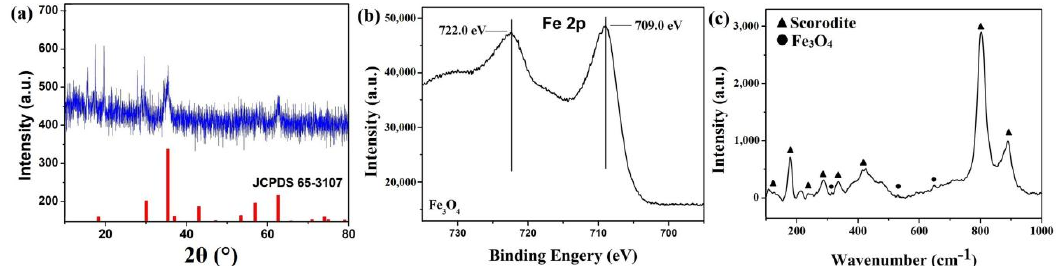
Figure 2. ( a ) XRD pattern, ( b ) XPS spectrum, and ( c ) Raman spectrum of as-synthesized scorodite@Fe 3 O 4 (initial Fe ions/scorodite molar ratio = 9%; initial reaction pH = 8; reaction time = 35 min).